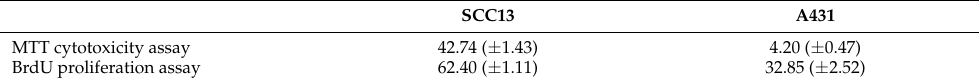
Table 1. Results * of MTT and BrdU assays of GP-2250 in both cSCC cell lines (SCC13 and